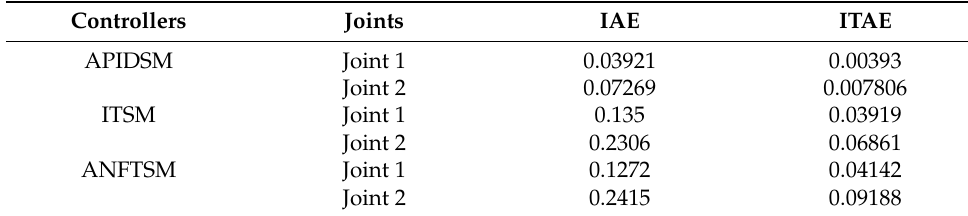
Table 3. Comparison of performance indicators.